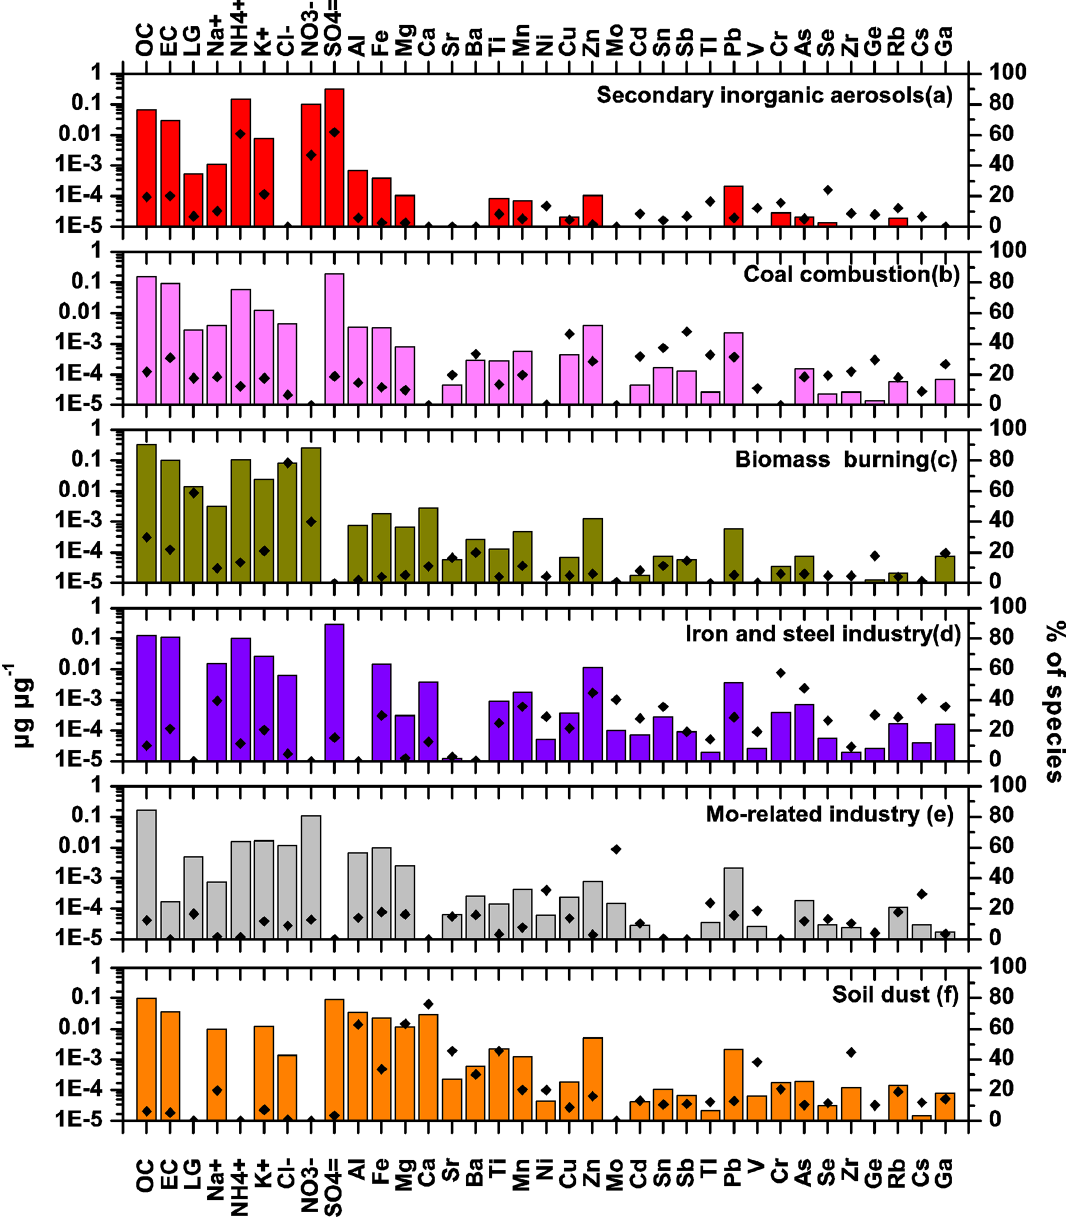
Figure 6. Six source profiles (bars) resolved from the PMF model (in units of µgµg − 1 ). Also shown are contribution percentages (black dots) from each source